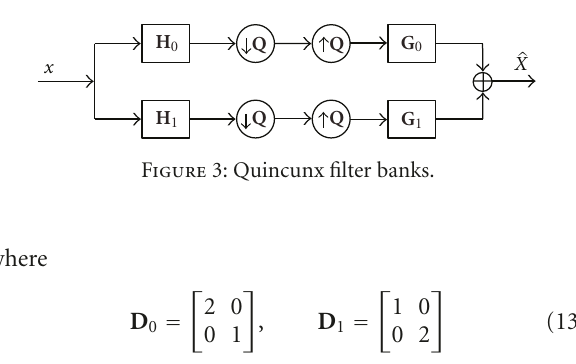
Figure 2: Identity for the analysis filter bank.